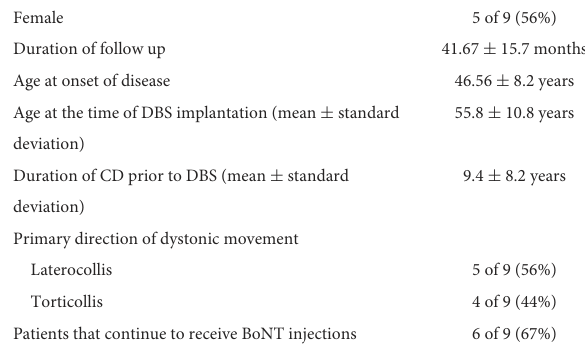
TABLE 1 Characteristics of